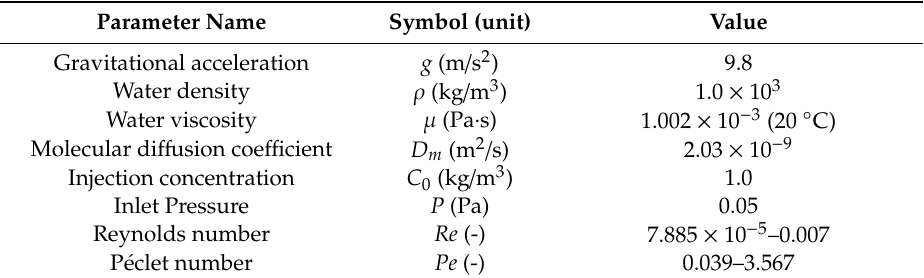
Table 1. Parameters and boundary conditions used in the